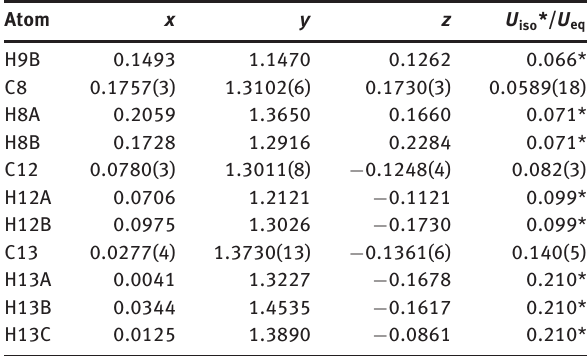
Table 2: Fractional atomic coordinates and isotropic or equivalent isotropic displacement parameters (Å 2